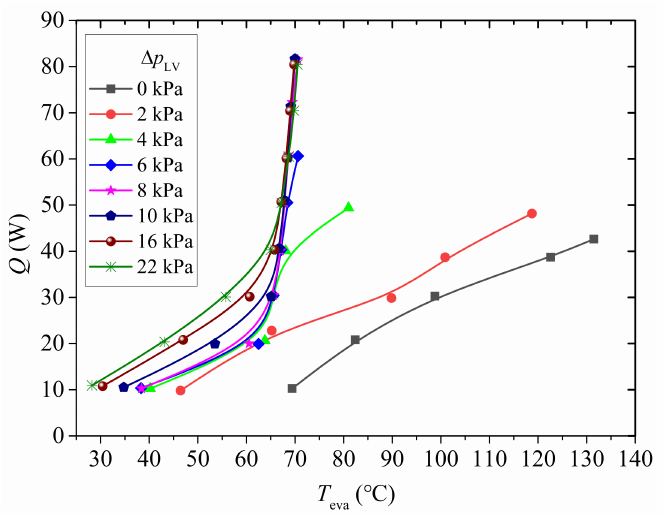
Figure 4. Variation in baseplate temperature under different liquid-vapor pressures and heating